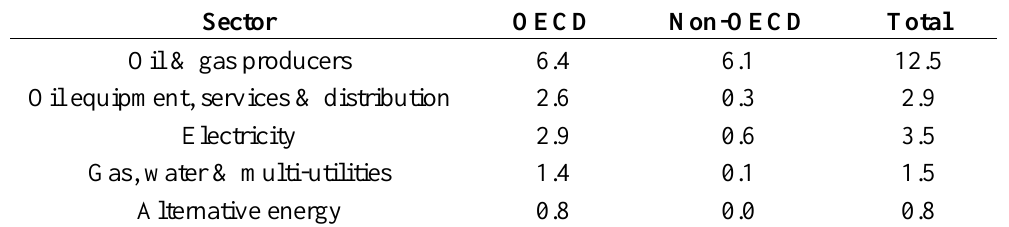
Table 4. Industry Energy R&D Spend among the 2000 Top R&D Companies 2012 ($ billion) [2].